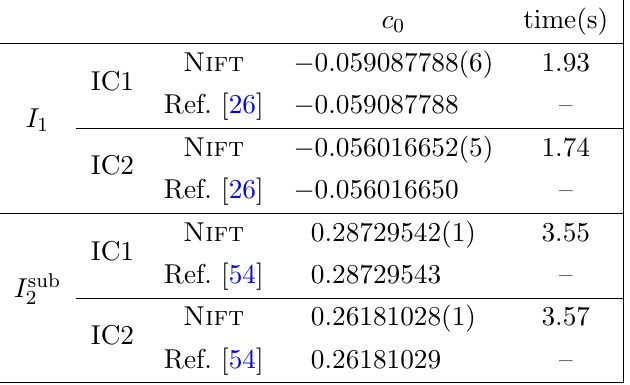
Table 2. The comparison of our numerical initial conditions obtained from Nift [48] with the analytical ones for the Feynman integral I 1 and I sub t = 0 : 891) and IC2( s = (cid:0) (cid:12)nite integrals.